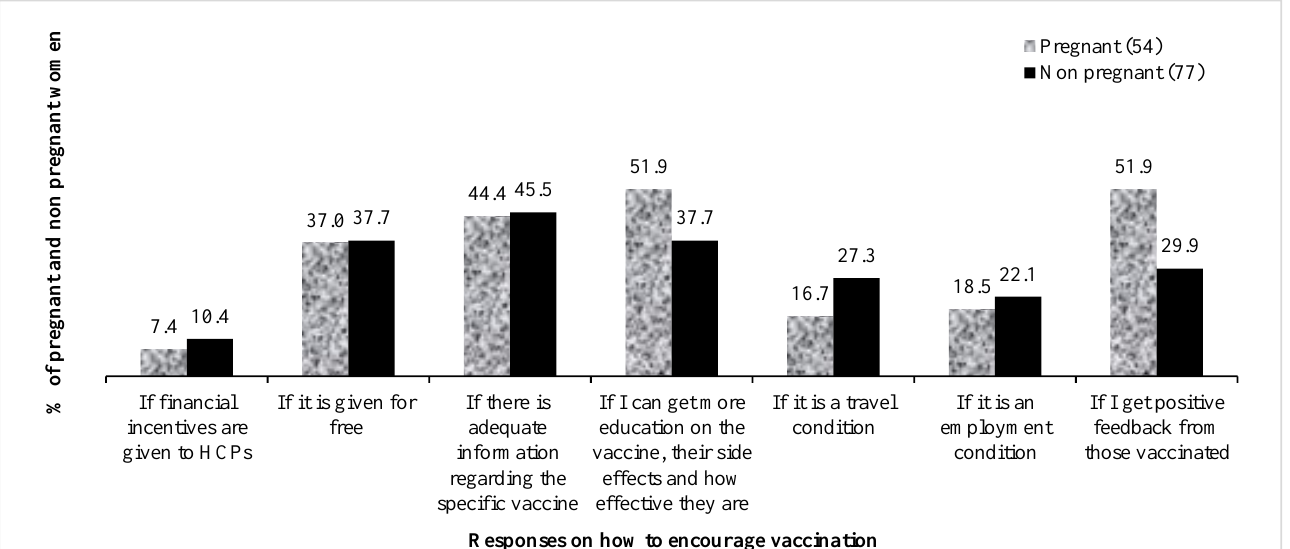
Figure 6. Conditions that would encourage acceptance of the COVID-19 vaccines. HCPs—healthcare practitioners.